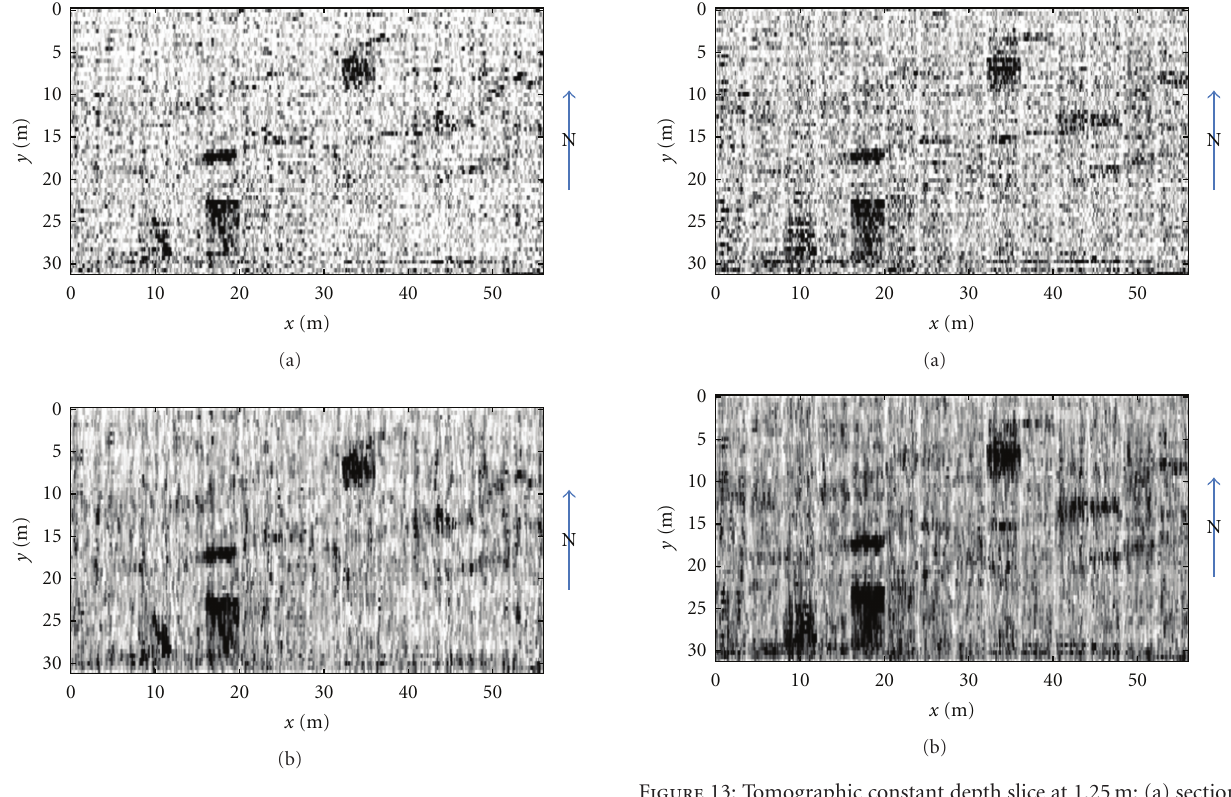
Figure 12: Tomographic constant depth slice at 1m: (a) section not interpolated; (b) section interpolated by a median filtering.